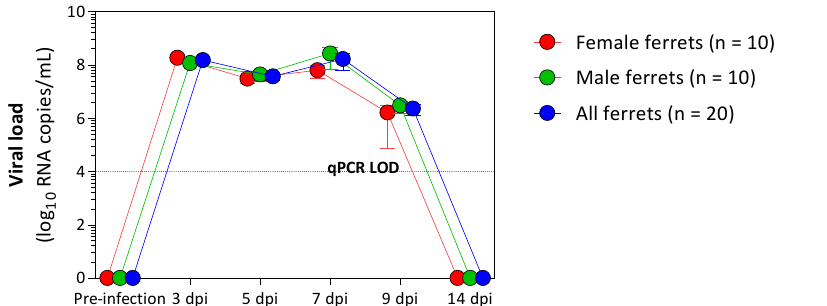
Figure 1. Viral RNA shedding in nasal washes collected from SARS-CoV-2-infected ferrets ( n = 20). Red and green dots represent female ( n = 10) and male ferrets ( n = 10), respectively, while all ferrets (both males and females) are annotated in blue. SARS-CoV-2 RNA was detected in nasal wash samples from ferrets at 3, 5, 7, and 9 dpi. The dotted line represents the limit of detection (LOD) of the reverse-transcription qPCR assay.